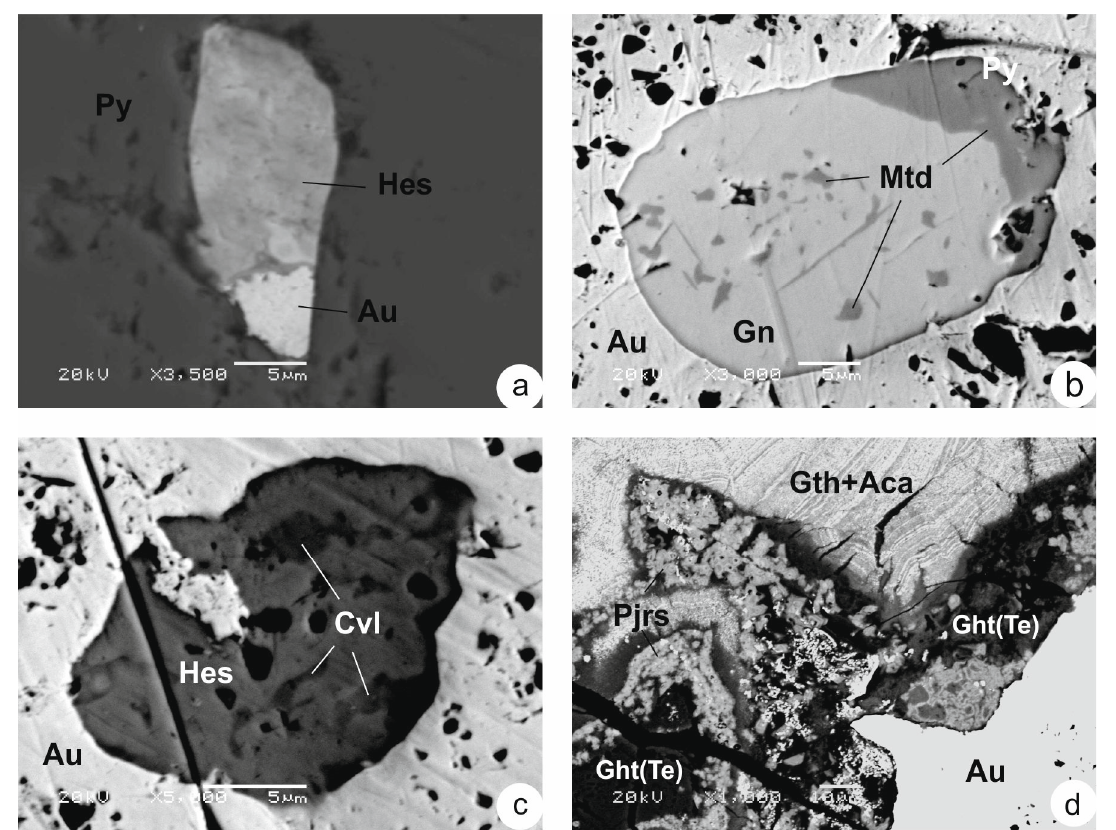
Figure 11. Mineral associations of gold: ( a )—association of hessite (Hes) and native gold (Au) in pyrite (Py); ( b , c )—relics of minerals in supergene gold: ( b )—galena (Gn) with phases and border of matildite (Mtd), ( c )—a mixture of hessite (Hes) with gold-containing cervelleite-like phase and microinclusions of cervelleite (Cvl); ( d )—the relationship of supergene gold (Au) with plumbojarosite (Pjrs), goethite enriched with tellurium, and goethite with rhythmic-zonal acanthite (Ght + Aca).